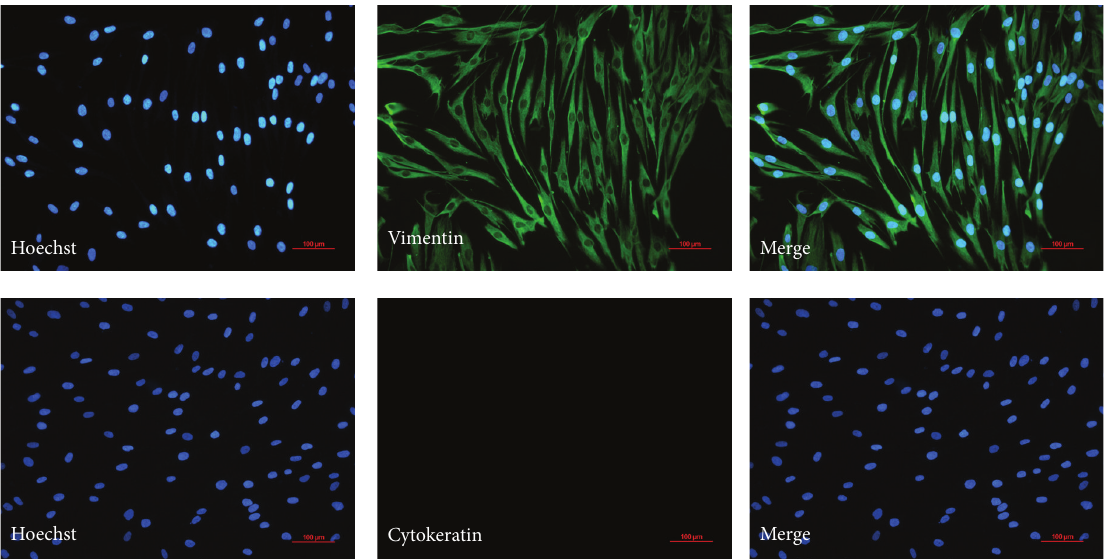
Figure 1: Identification of human Tenon capsule fibroblasts. A vimentin and cytokeratin immunostaining technique was used to detect fibroblast feature of the cultured cells. Fibroblast produced vimentin constitutively with the cytoplasm staining positively (in green). But cytokeratin staining in the fibroblast is negative. Nuclei stained with Hoechst were seen in blue.